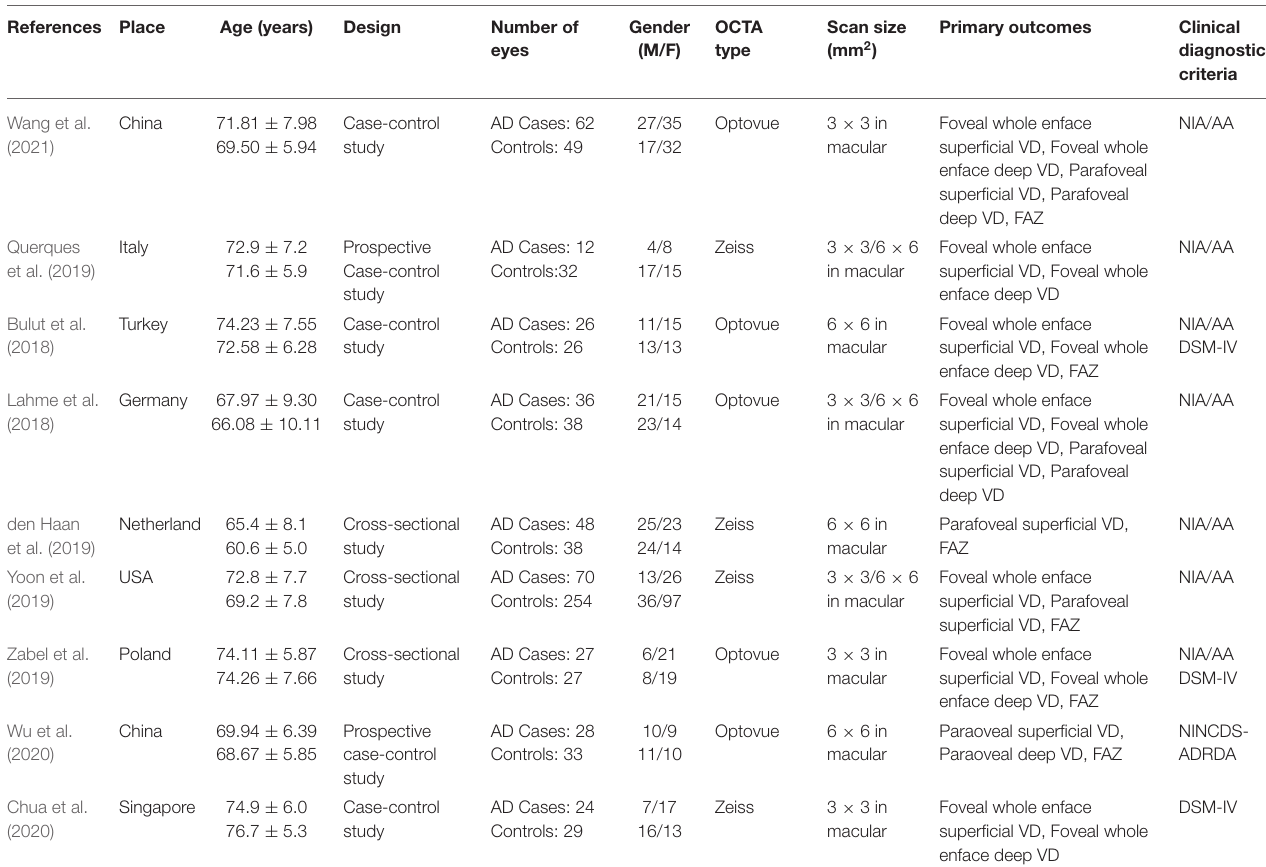
TABLE 1 | General characteristics of the eligible studies.